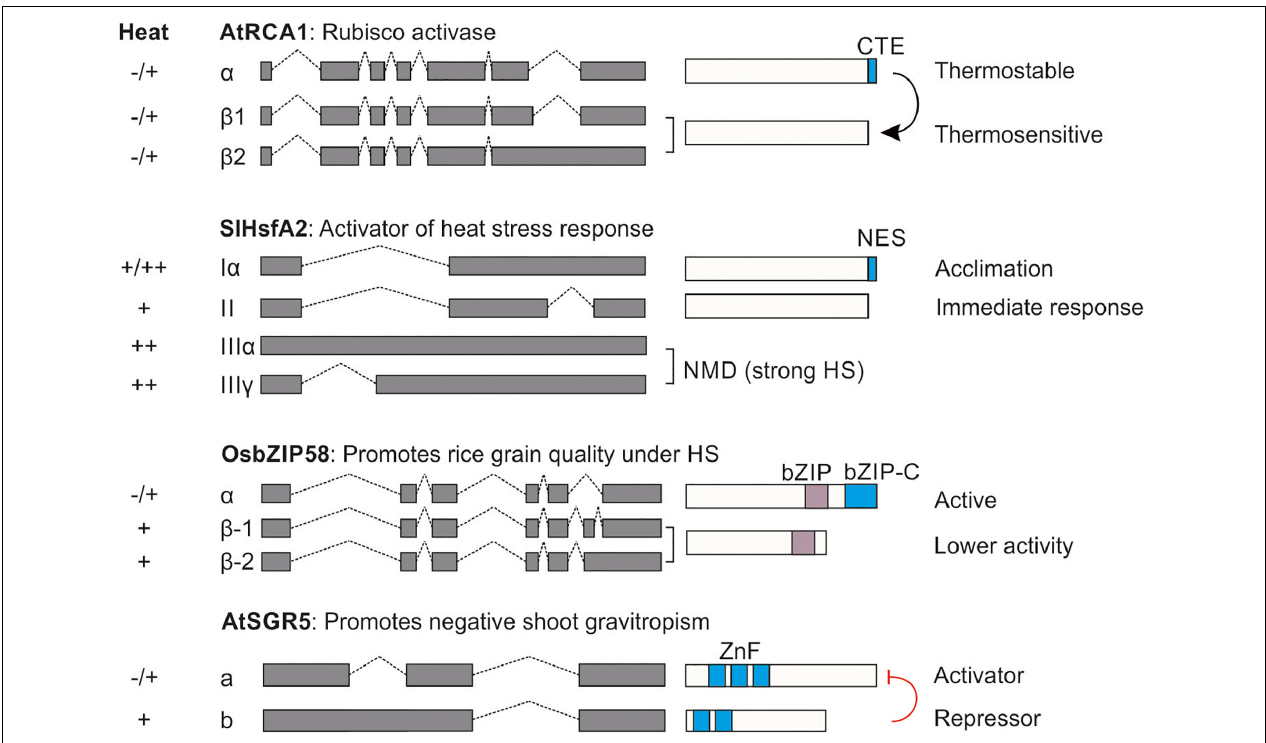
FIGURE 2 | Relevance of alternative splicing for thermotolerance. Four examples for the effect of AS on the generation of protein isoforms with distinct functions. The presence of the isoform under control (–), mild (+) and strong (++) heat stress conditions is shown on the left. CTE, C-terminal extension; NES, nuclear export signal; bZIP-C, C-terminal basic leucine zipper; ZnF, Zinc finger. The black arrow in AtRCA1 indicates protection of the thermosensitive isoform. The red line indicates inhibition. Details for each case can be found in see section “Gene-Specific Studies Showcasing the Significance of Alternative Splicing for Plant